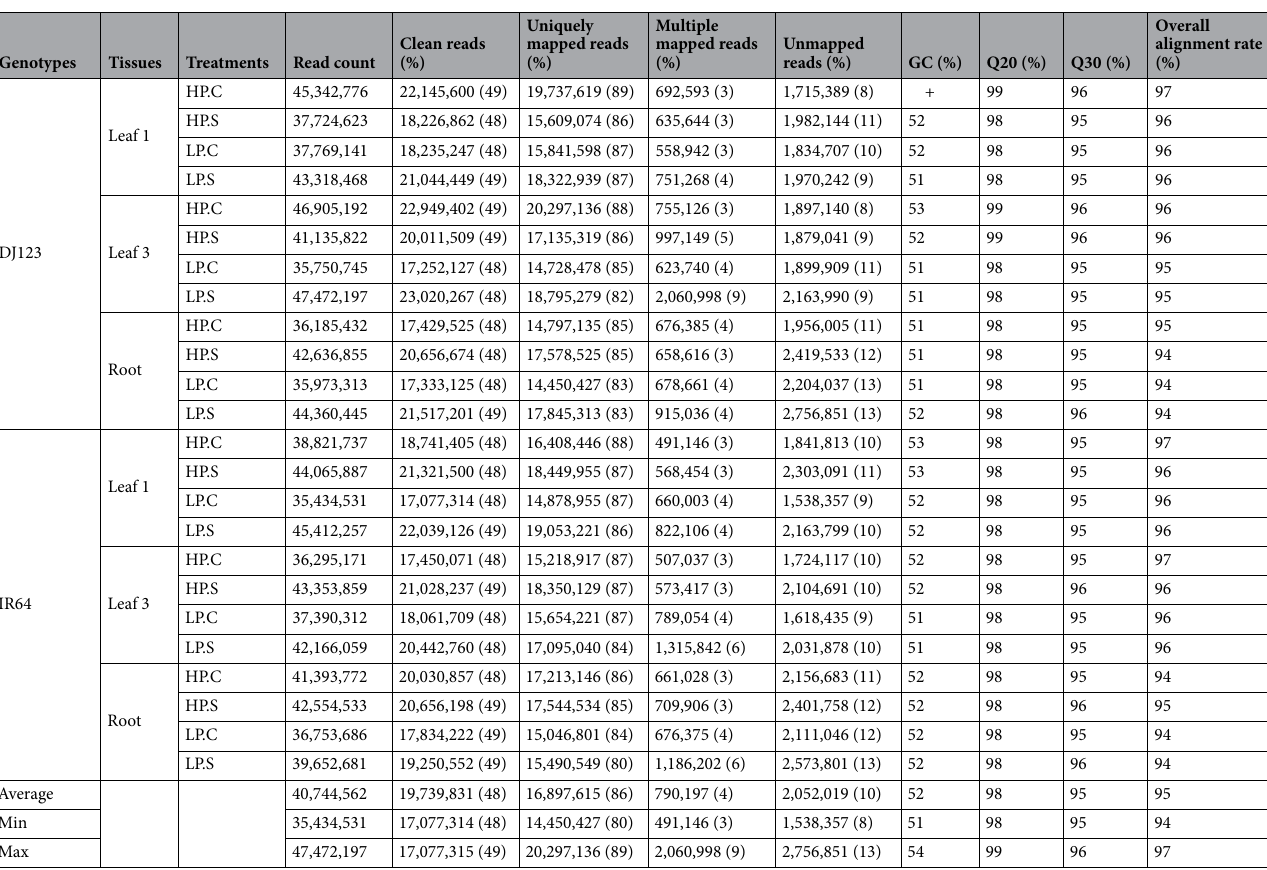
Table 1. RNA-seq data